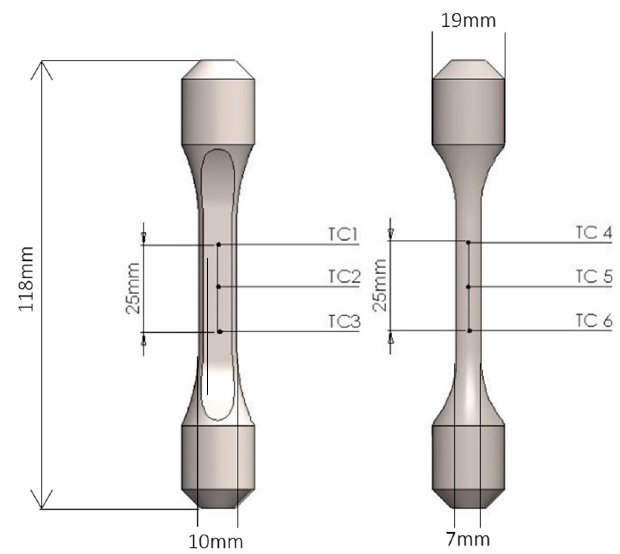
Figure 1. Thermocouple positions for thermal profiling. The positions of the outermost thermocouples define the position of the extensometer arms and the region of temperature-controlled material in the TMF cycle.